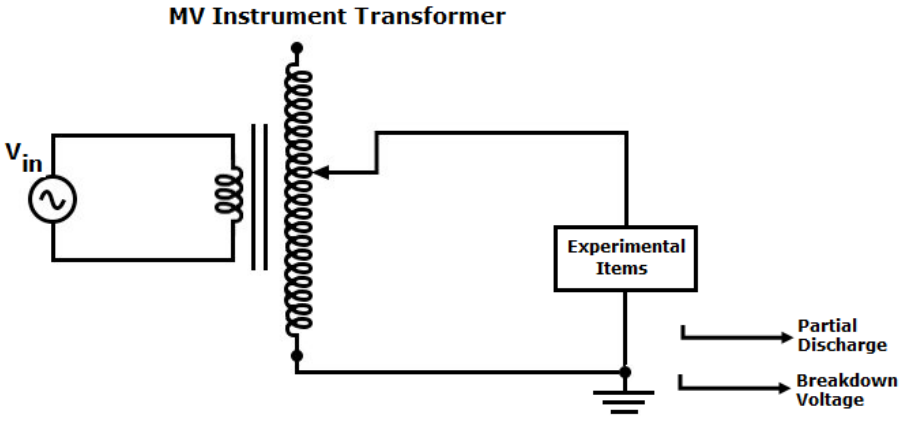
Figure 5. Wiring diagram for partial discharge test setup.